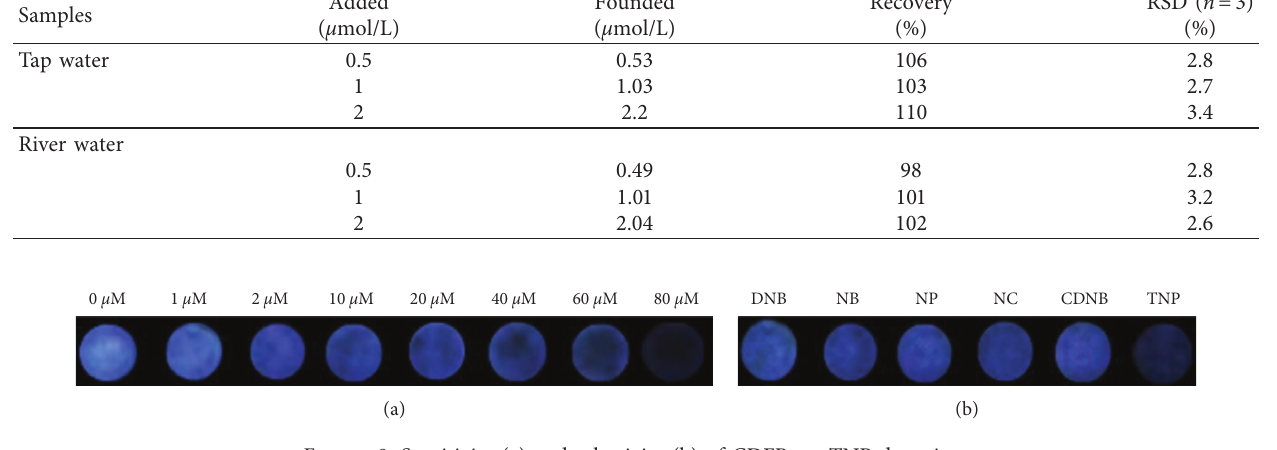
Figure 7: (a, b) The efficiency of fluorescence quenching of CDs in the presence of different analytes. I intensity of CDs in the absence and presence of different analytes, respectively. Table 2: Results of the recovery analysis of TNP in water samples. Added Samples